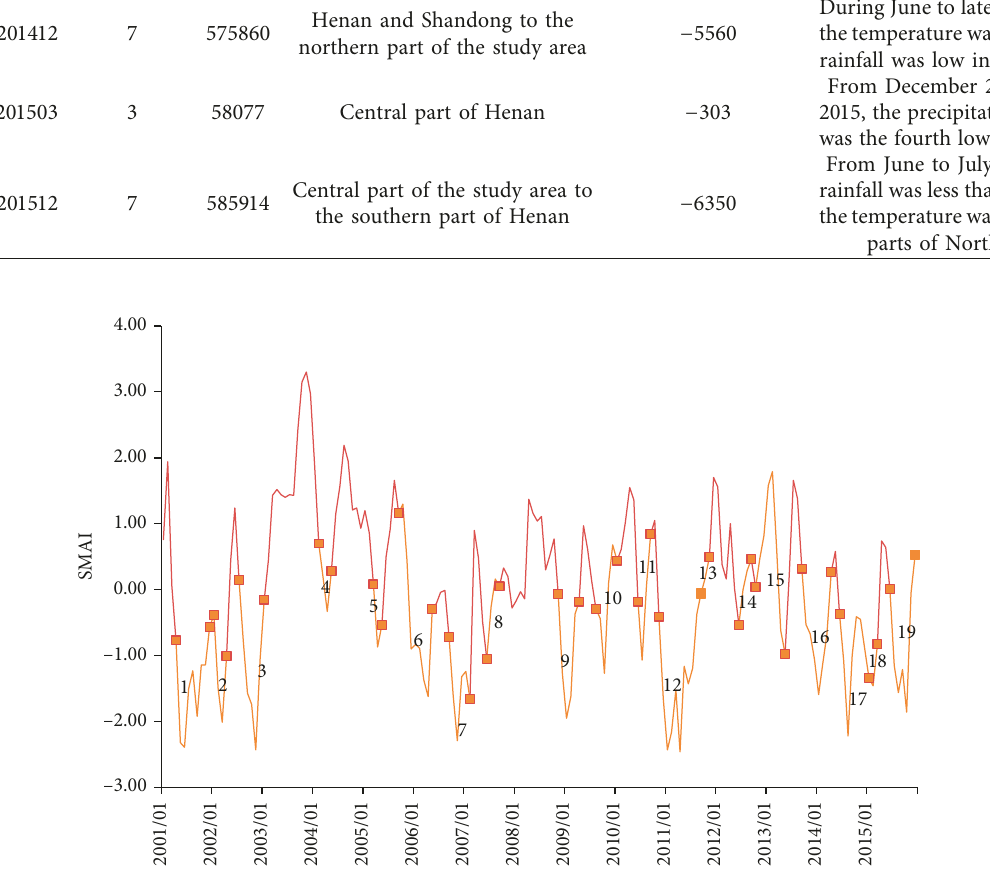
Figure 5: The time period of 19 persistent drought events (orange) in North China during 2001–2015 marked on monthly time series of the average SMAI (red).